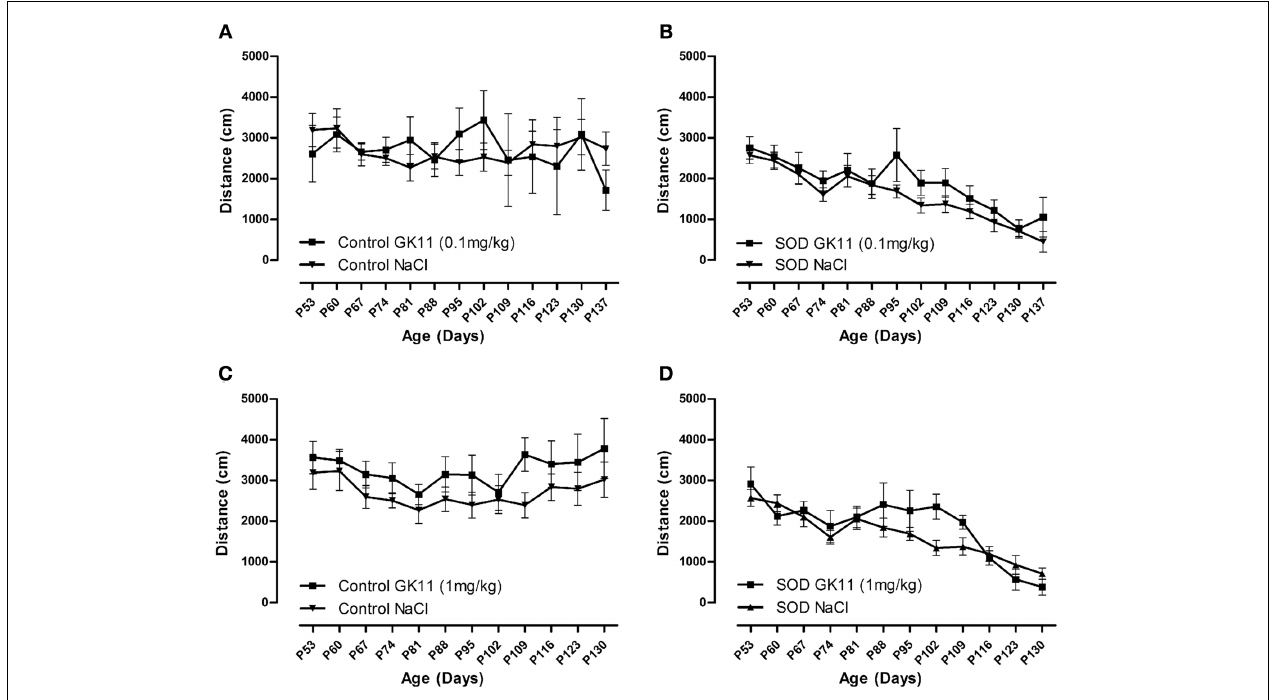
FIGURE 4 | Evaluation of Gacyclidine effects on the spontaneous motor activity of hSOD1 G93A mice: Open Field analysis. Spontaneous locomotor activity represented by the mean distance covered by female controls and hSOD1 G93A mice in a weekly 8min recording test over disease progression